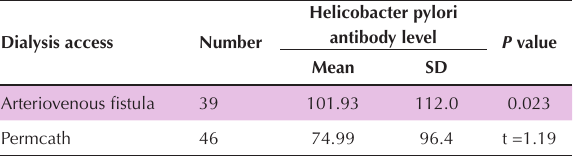
Table 6. Comparison of mean Helicobacter pylori antibody levels based on hemodialysis accesses Dialysis